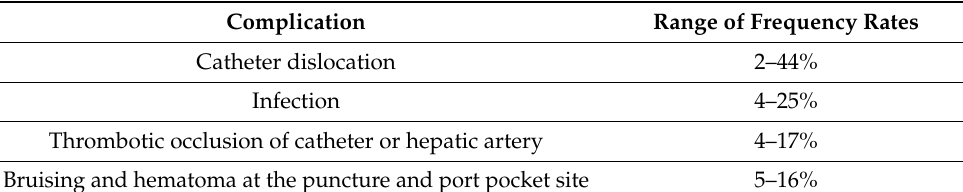
Table 1. Procedure-related complications and their